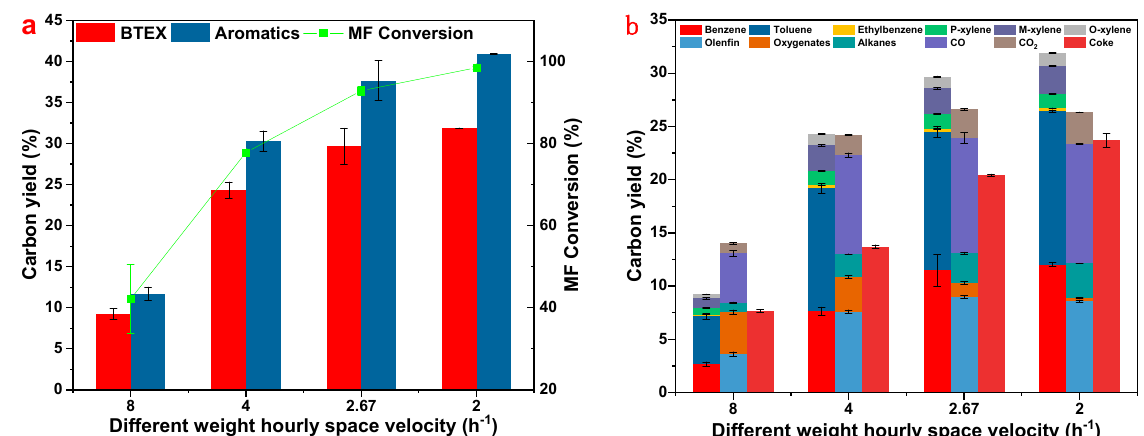
Figure 3. Effect of WHSV on the product distribution from CFP of bio-derived MF: ( a ) carbon yields of BTEX, aromatics, and MF conversion; ( b ) carbon yields of benzene, toluene, ethylbenzene, xylene, olefins, oxygenates, alkane, CO, CO 2 , and coke. Reaction conditions: 550 °C, catalyst: 2%Fe-ZSM-5, carrier gas flow rate: 120 mL/min, reaction time: 15 min.